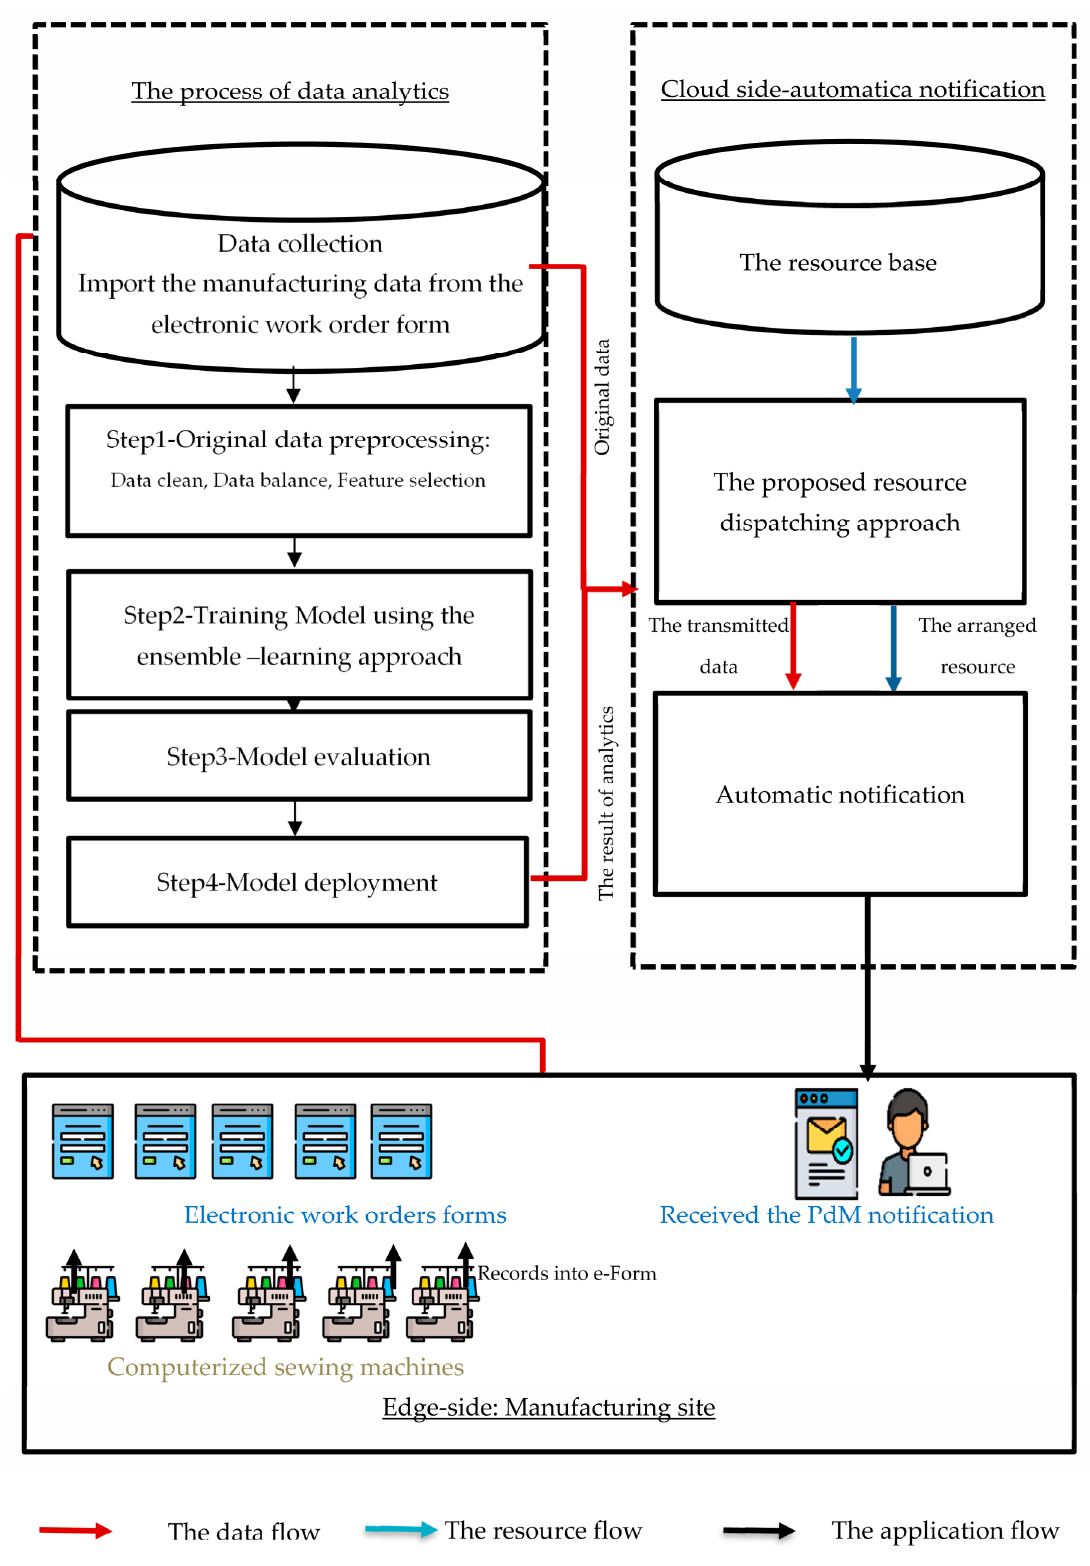
Figure 1. The flowchart of the data analytics in this study.